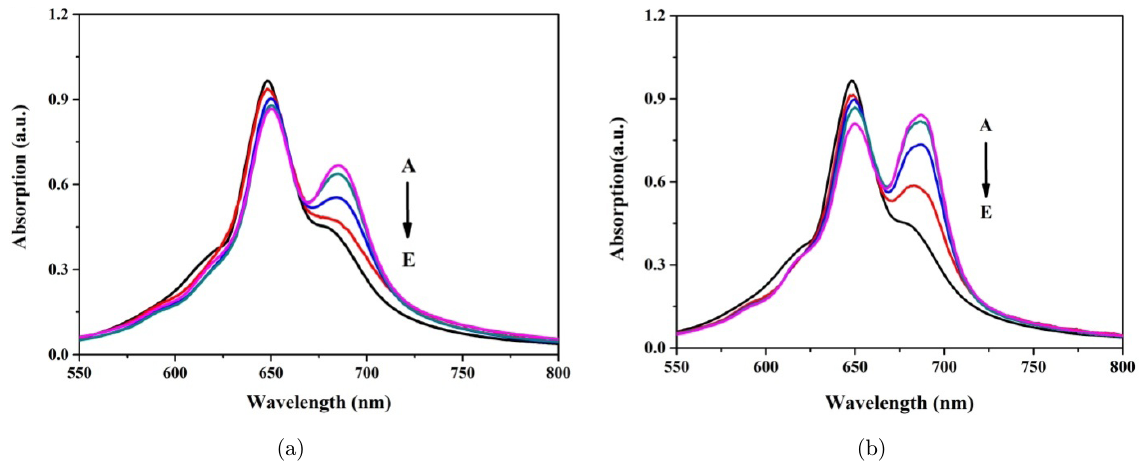
Fig. 2. Aggregation behavior of AlPc in water in the presence of BSA (a) and HSA (b) at various concentrations: A